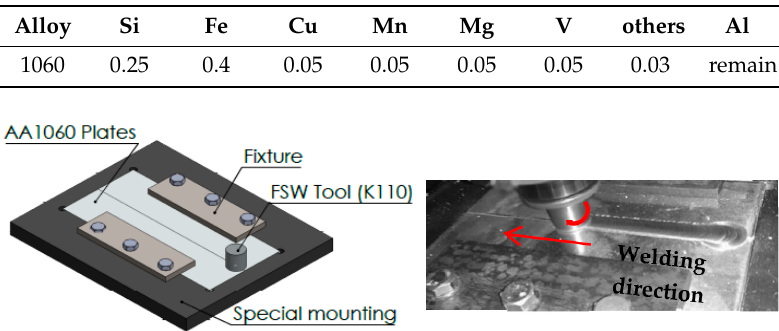
Table 1. Chemical composition of AA1060 (wt. %).